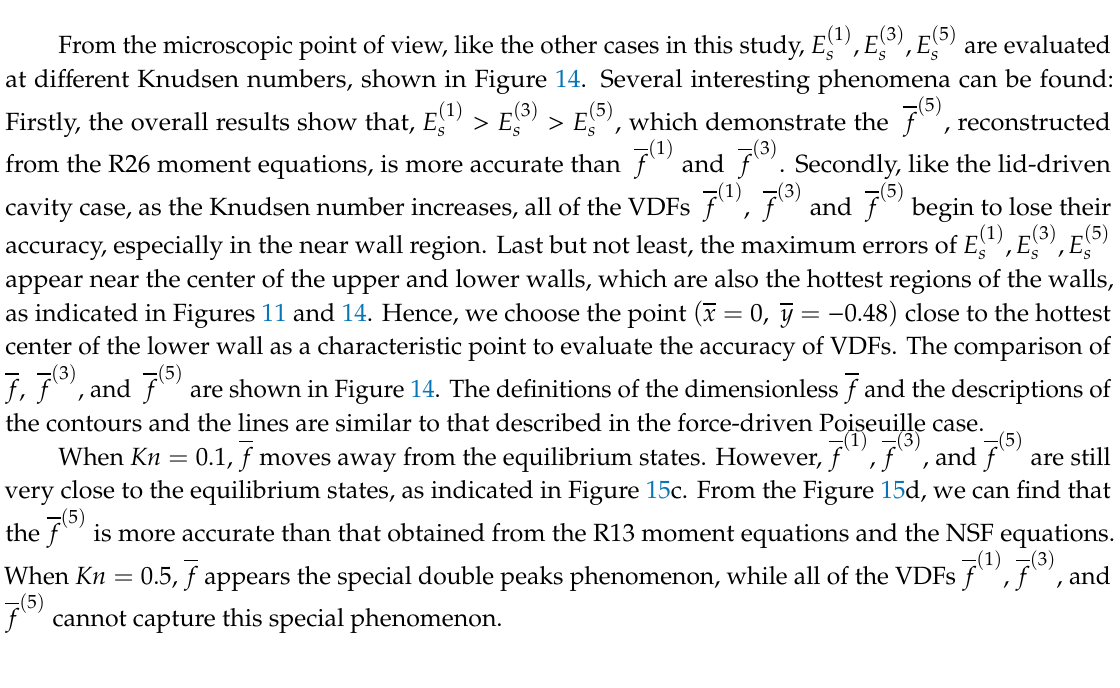
Figure 13. Temperature profiles T = T / T 0 along the vertical center ( a – c ) and the horizontal center lines ( d – f ) at different Knudsen numbers.